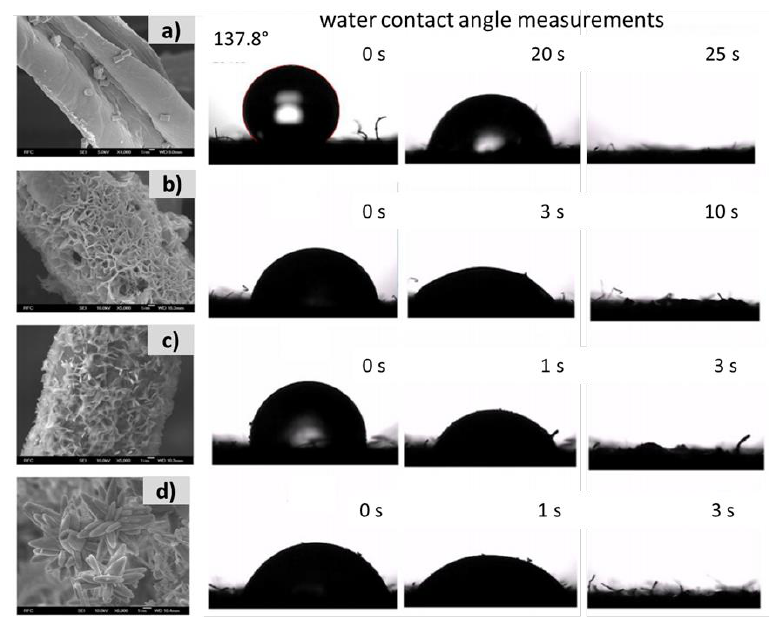
Figure 10. Surface morphology of ZnO-coated cotton fabric synthesized at pH 4–5 ( a ), pH 6 − 7 ( b ), pH